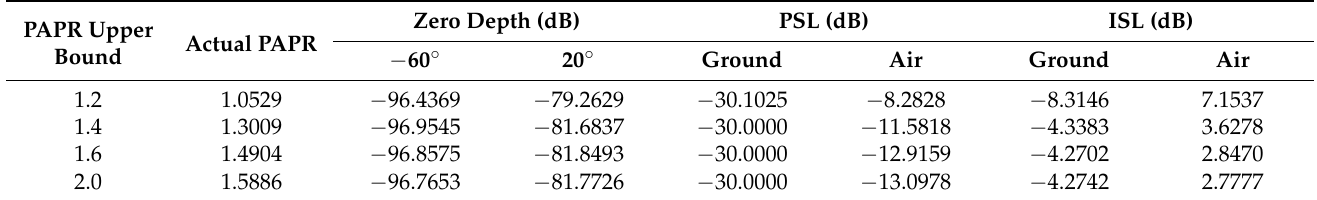
Table 3. Comparisons on the performances of the PAPR, zero depth, PSL, and ISL for different PAPR upper bounds.